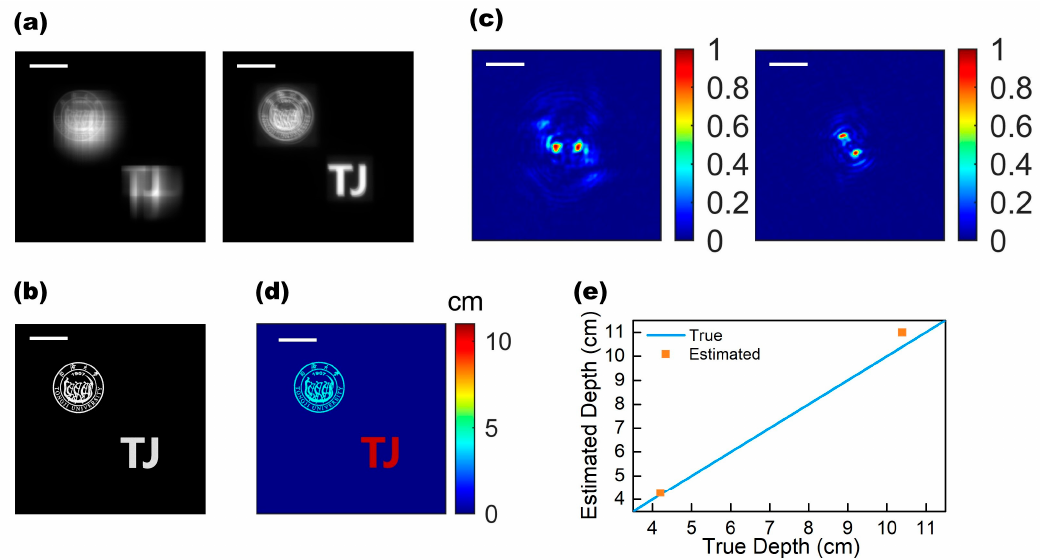
Figure 5. Dual-object depth imaging. ( a ) Convolution blurred images of two objects with different depths. EDOF metalens image ( left ) and DH-PSF metalens image ( right ). Scale bar: 0.4 mm . ( b ) Re- constructed images of two objects. Scale bar: 0.4 mm . ( d ) Depth map of two objects (near badge and far “TJ” character). Scale bar: 0.4 mm . ( c ) The DH-PSFs of the two objects were estimated using the image in ( a ). DH-PSF of the school emblem ( left ) and DH-PSF of the “TJ” character ( right ). Scale bar: 64 μm . ( d ) Depth map of two objects (near school emblem and far “TJ” character). Scale bar: 0.4 mm . ( e ) The comparison between the estimated depth of the two objects (orange points) and the actual depth (blue line).